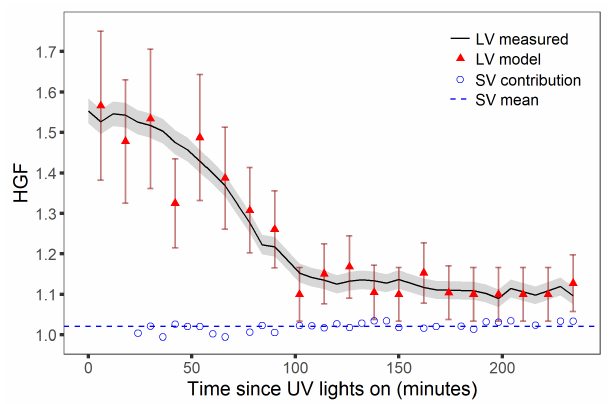
Figure 6. Comparison between measured (black line) and modelled (triangles) HGFs for the lower volatility component during SOA formation. The shaded region shows ± 2% uncertainty in H-SMPS measurements, while error bars represent composition-dependent uncertainties for this model. The derived HGF of the semi-volatile component is shown for contrast.